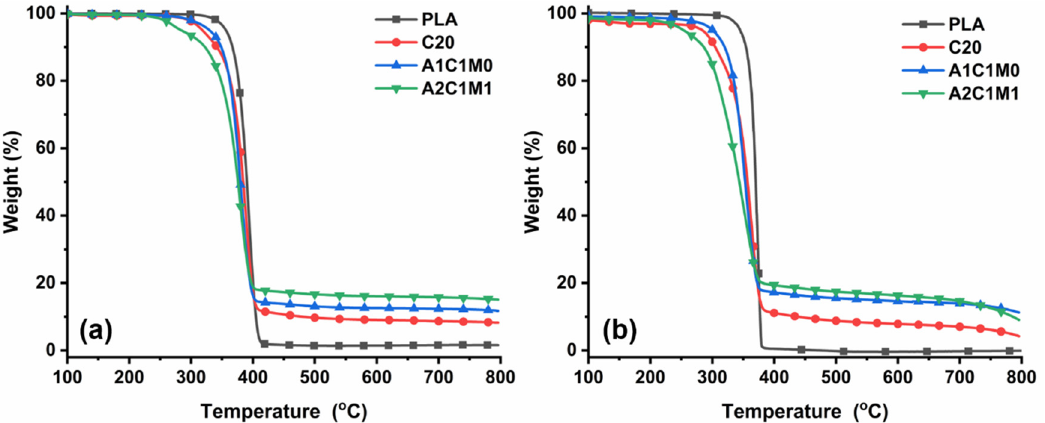
Figure 5. TGA curves of PLA and PLA composites under N 2 ( a ) and air ( b ) atmospheres.